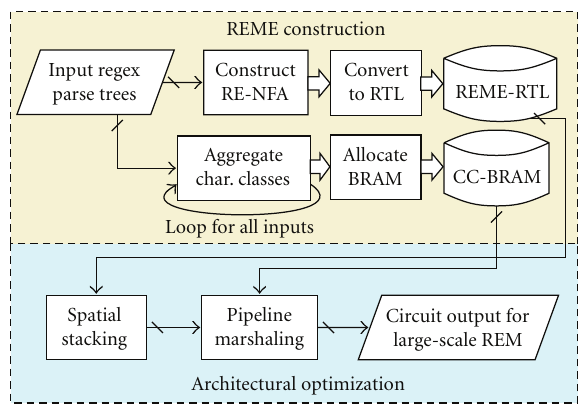
Figure 2: Overview of our toolchain for large-scale REME con- struction.